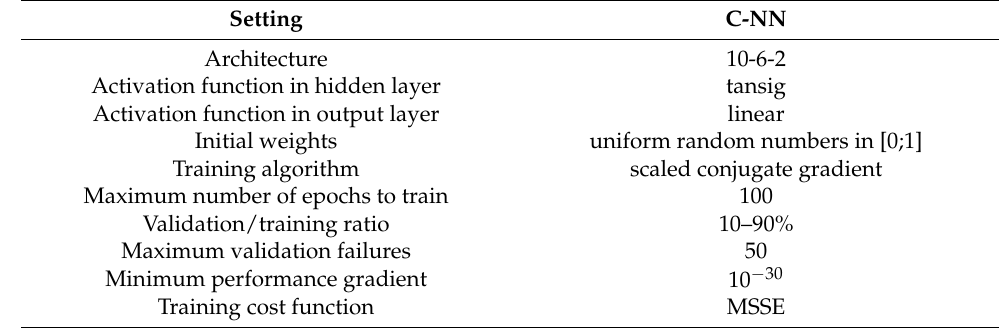
Table 5. VSFRT C-NN